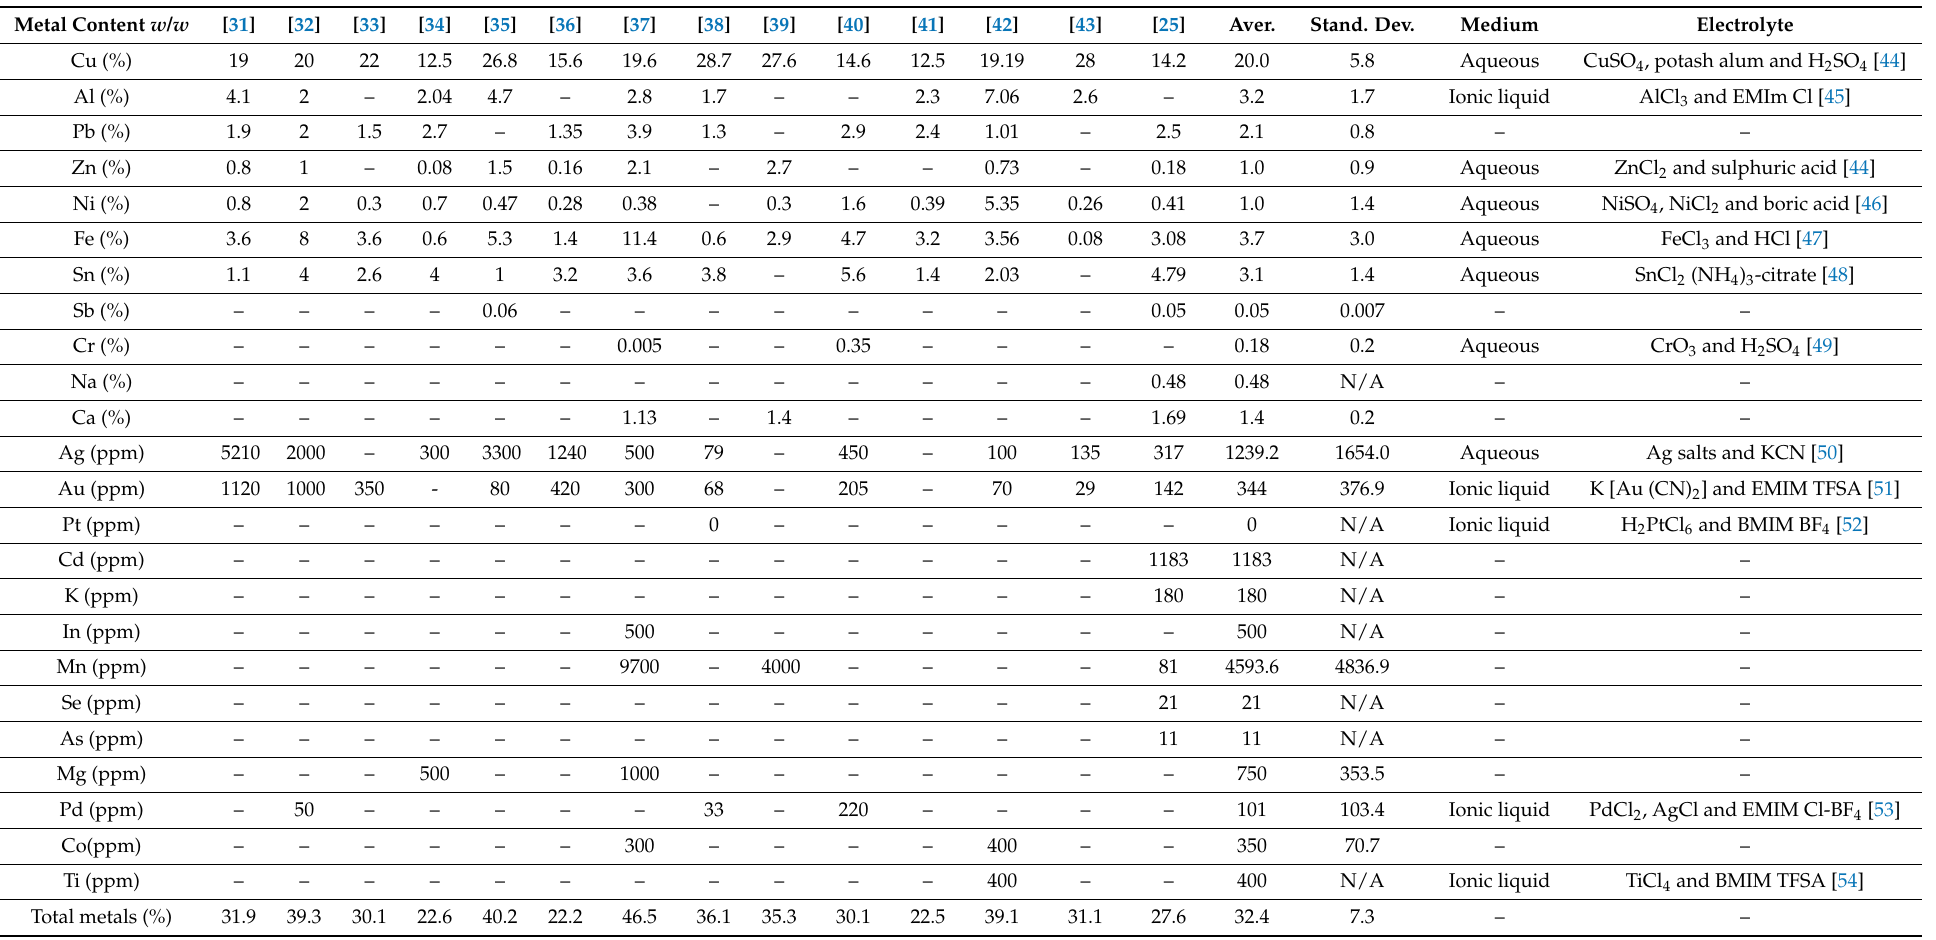
Metals present (% average) in e-waste PCB reported in literature. Ionic liquid full names and abbreviations are as such: n-butyl-n-methylpyrrolidinium bis(trifluoromethylsulfonyl)imide (BMP TFSA), 1-Ethyl-3-methylimidazolium bis(trifluoromethylsulfonyl)imide (EMIM TFSA), 1-Ethyl-3-methylimidazolium chloride (EMIm Cl), 1-Ethyl-3-methylimidazolium—tetrafluoroborate (EMIM Cl-Bf4), 1-Butyl-3-methylimidazolium tetrafluoroborate (BMIM